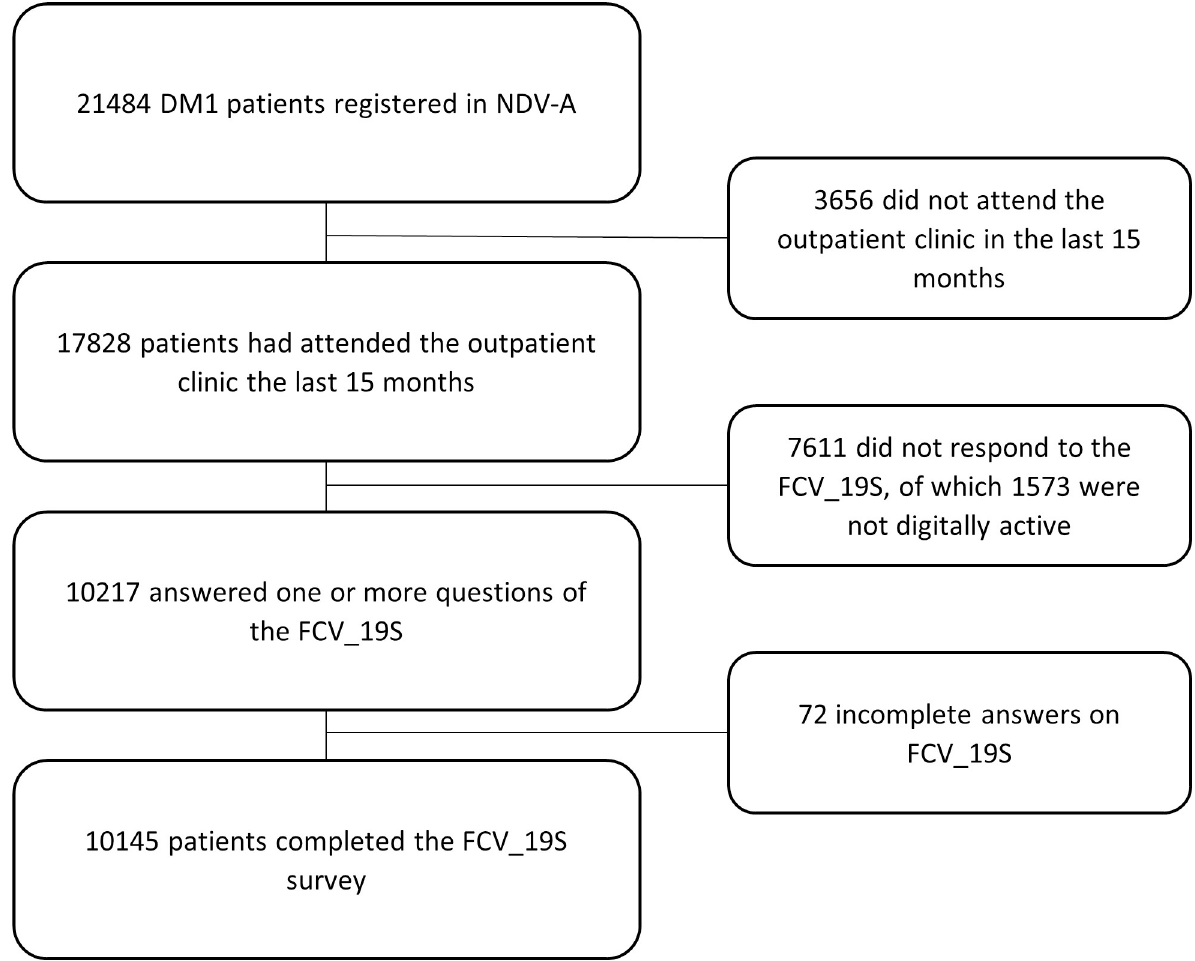
Fig 1. Flowchart illustrating the inclusion of patients in the